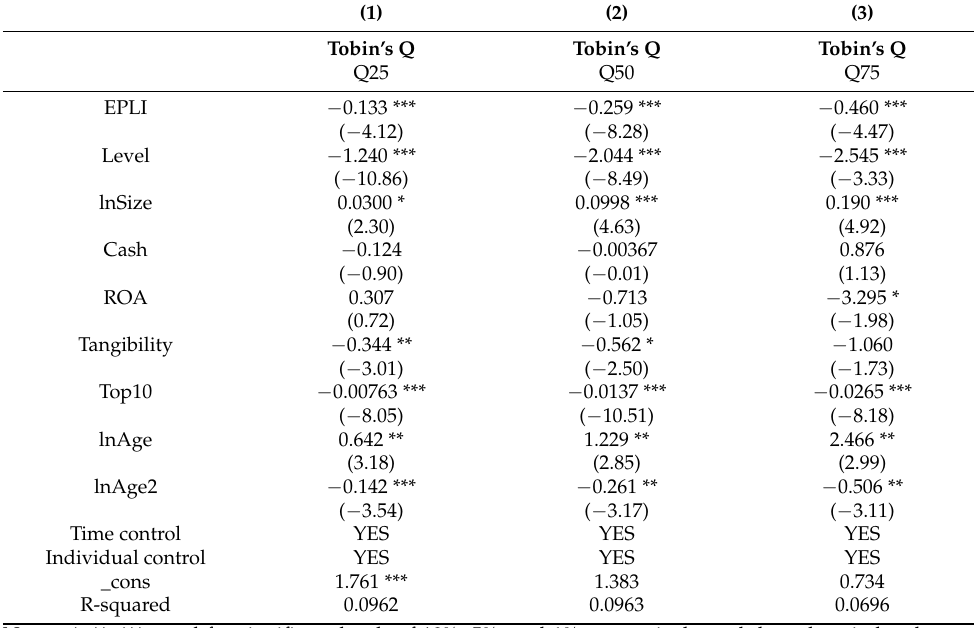
Table 5. Robustness test of quantile